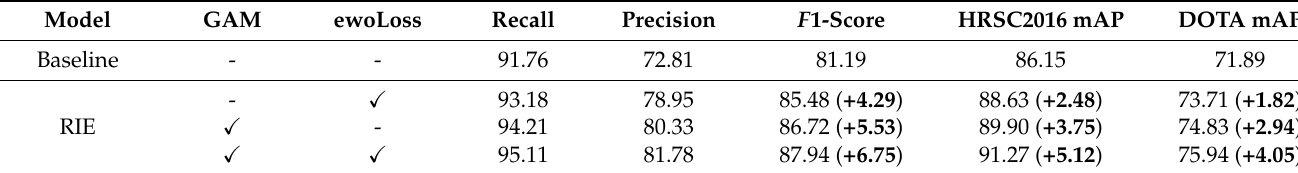
Table 4. Ablation study of the RIE. All of the models were implemented on the HRSC2016 and DOTA datasets. Model